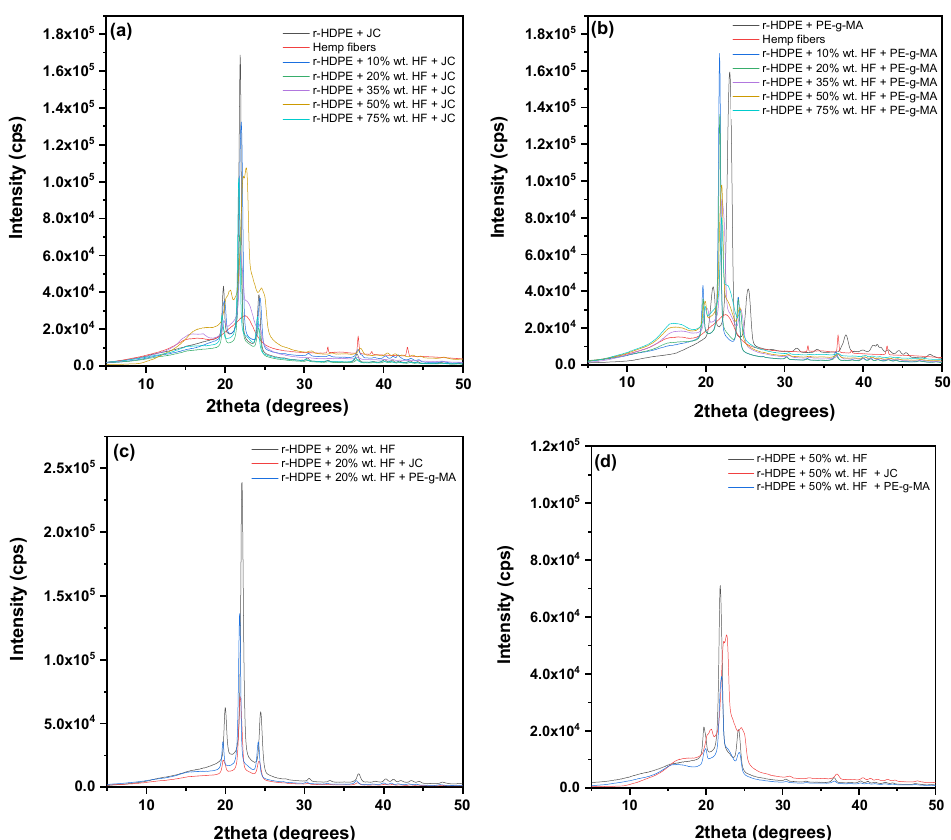
Figure 4. Comparative XRD patterns of the prepared ( a ) recycled high-density polyethylene (r-HDPE) + hemp fibers (HF) + Joncryl (JC), ( b ) r-HDPE + HF + polyethylene-grafted maleic anhydride (PE-g-MA) composite materials, ( c ) r-HDPE + 20% wt. HF with different compatibilizers, and ( d ) r-HDPE + 50% wt. HF with different compatibilizers.